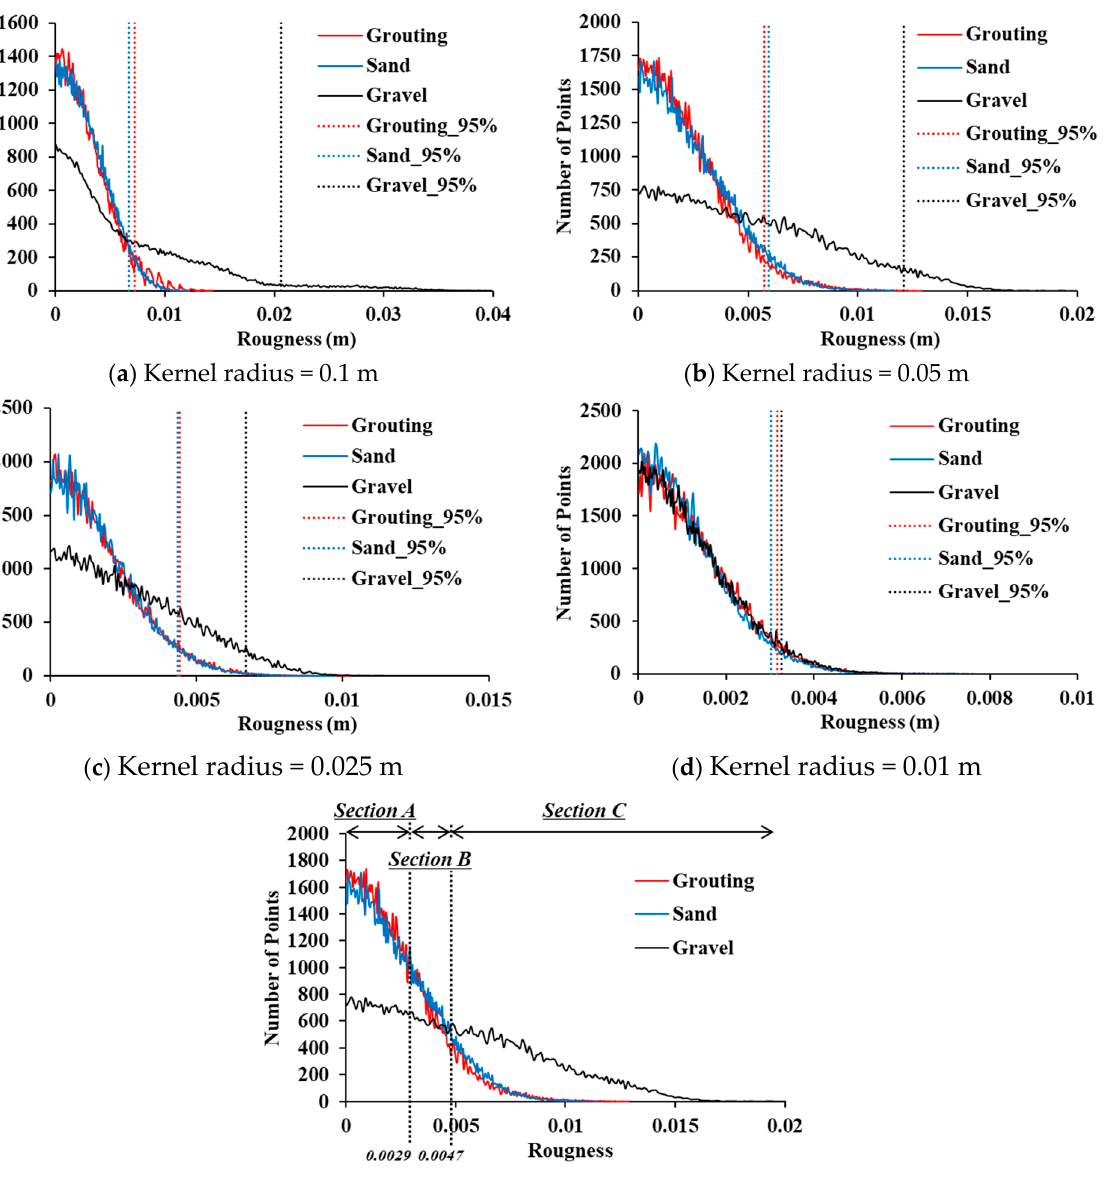
Figure 11. Roughness histograms for of three samples with different kernel radius.